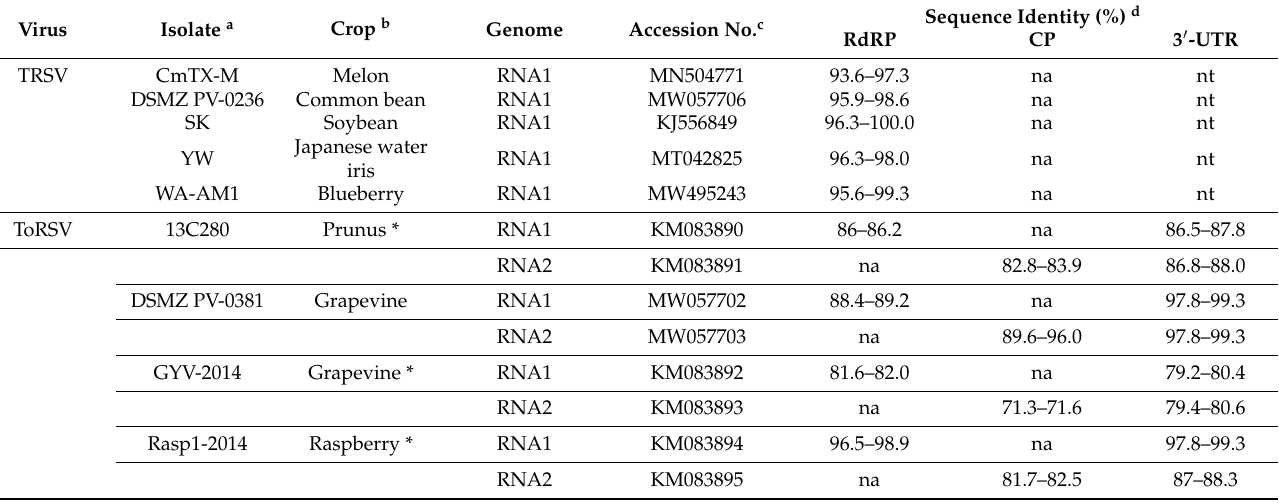
Table 4. Nucleotide sequence identities of tobacco ringspot virus (TRSV) and tomato ringspot virus (ToRSV) isolates from pawpaw trees and other crops in the RNA-dependent RNA polymerase (RdRP), coat protein (CP), and 3 (cid:48) untranslated (3 (cid:48) -UTR) genomic